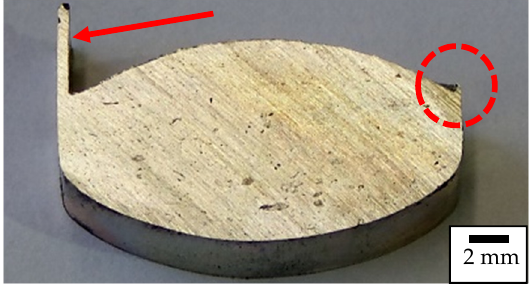
Figure 2. Formed oval cross-section of the magnesium wire pre-profile (AZ31); red markings indicate the burrs formed double-sided on the upper side of the wire.